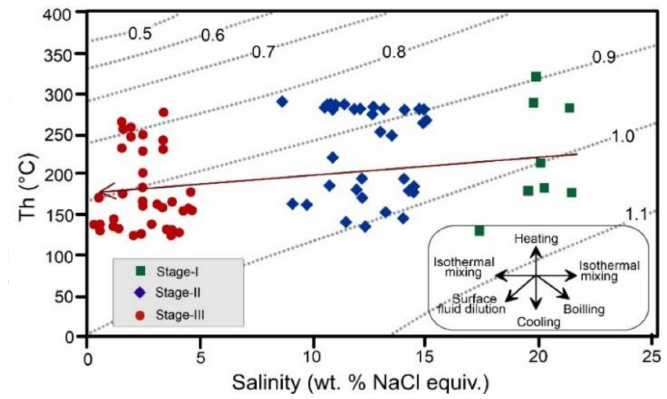
Figure 20. Homogenization temperature (Th) versus salinity (wt % NaCl eq.) plot of fluid inclusion data in the Shah-Ali-Beiglou deposit showing isothermal mixing trend during mineralization (Doted lines indicate density curves after Wilkinson,